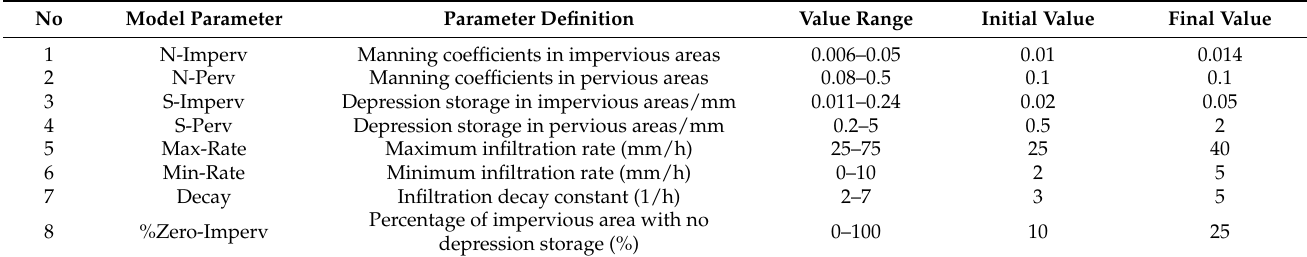
Table 2. Calibration and validation results of model parameters in SWMM.